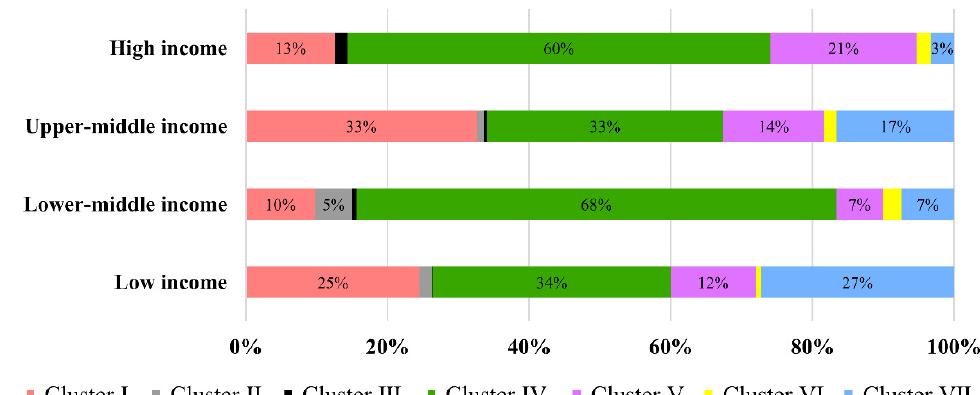
Figure 6. The proportions of cities for the seven clusters in each income